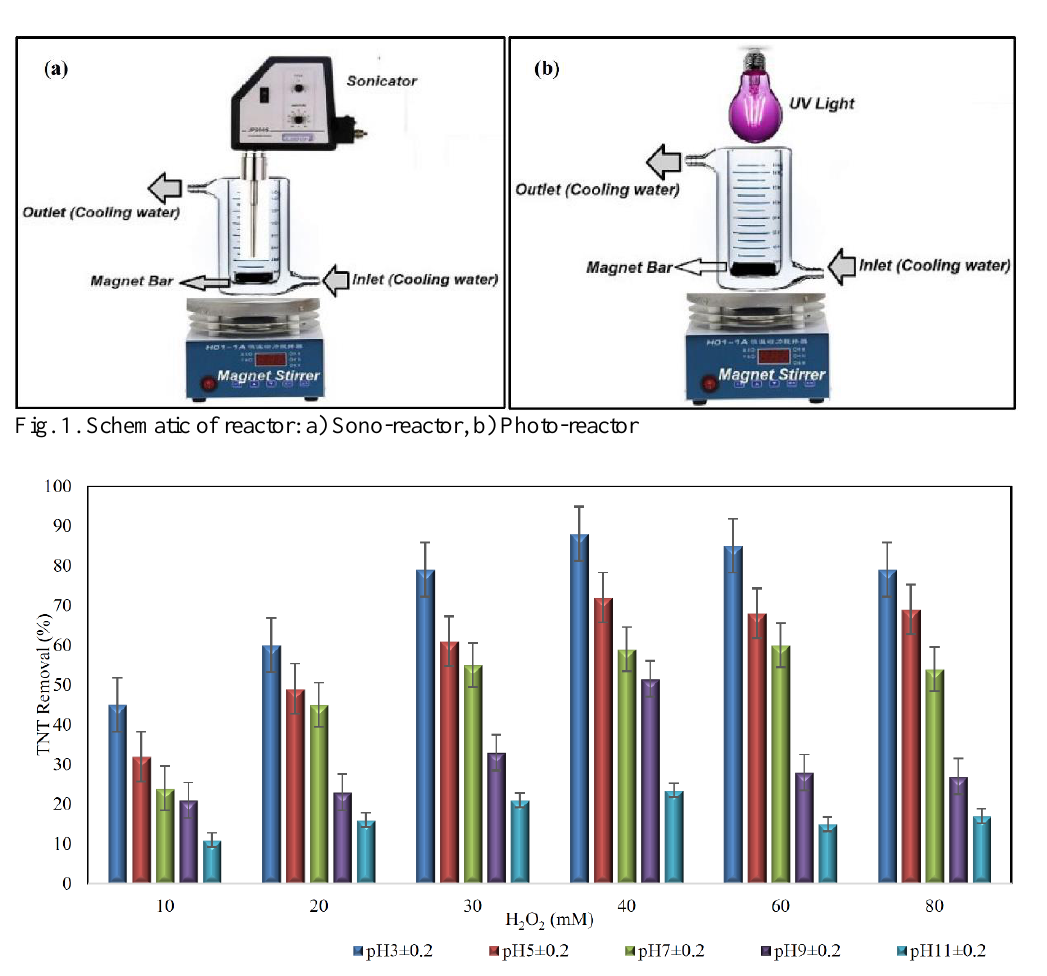
Fig. 2. Effects of hydrogen peroxide concentrations (various pH) on removal of TNT by photo-Fenton and sono-Fenton